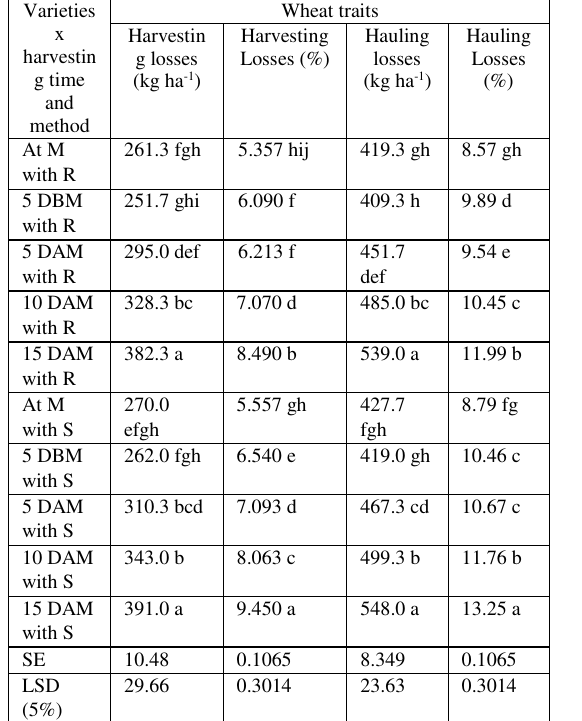
Table 4: Interactive effect of wheat varieties X harvesting time and method on wheat harvest and hauling losses traits (mean data of two years 2008-09 & 2009-10)